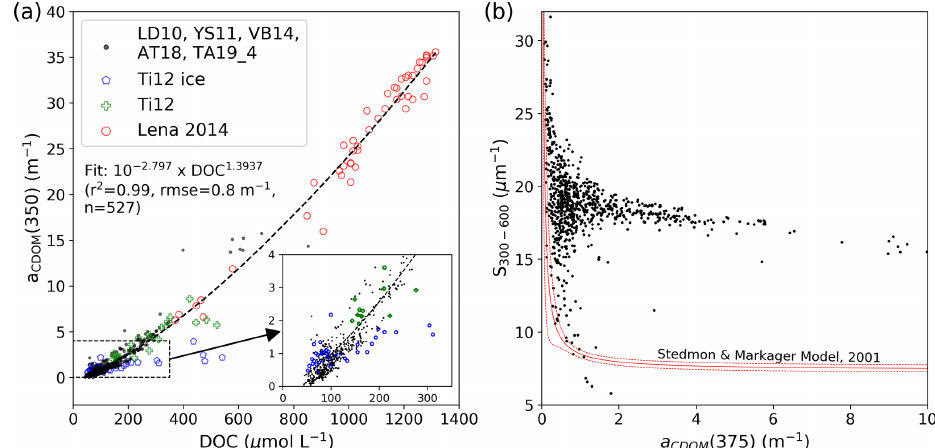
Figure 2. (a) The relationship between DOC and a CDOM (350) for Lena River water, ice samples and seawater samples from the LS and ESS. The regression and r 2 was calculated only on the basis of river and seawater samples. Panel (b) shows the model developed by Stedmon and Markager (2001) to differentiate between marine and terrestrial organic matter. Data points from the LS and ESS that lie within the model boundaries of the Stedmon and Markager (2001) model (dotted red lines) are defined as marine CDOM, while the rest are terrestrial in origin.